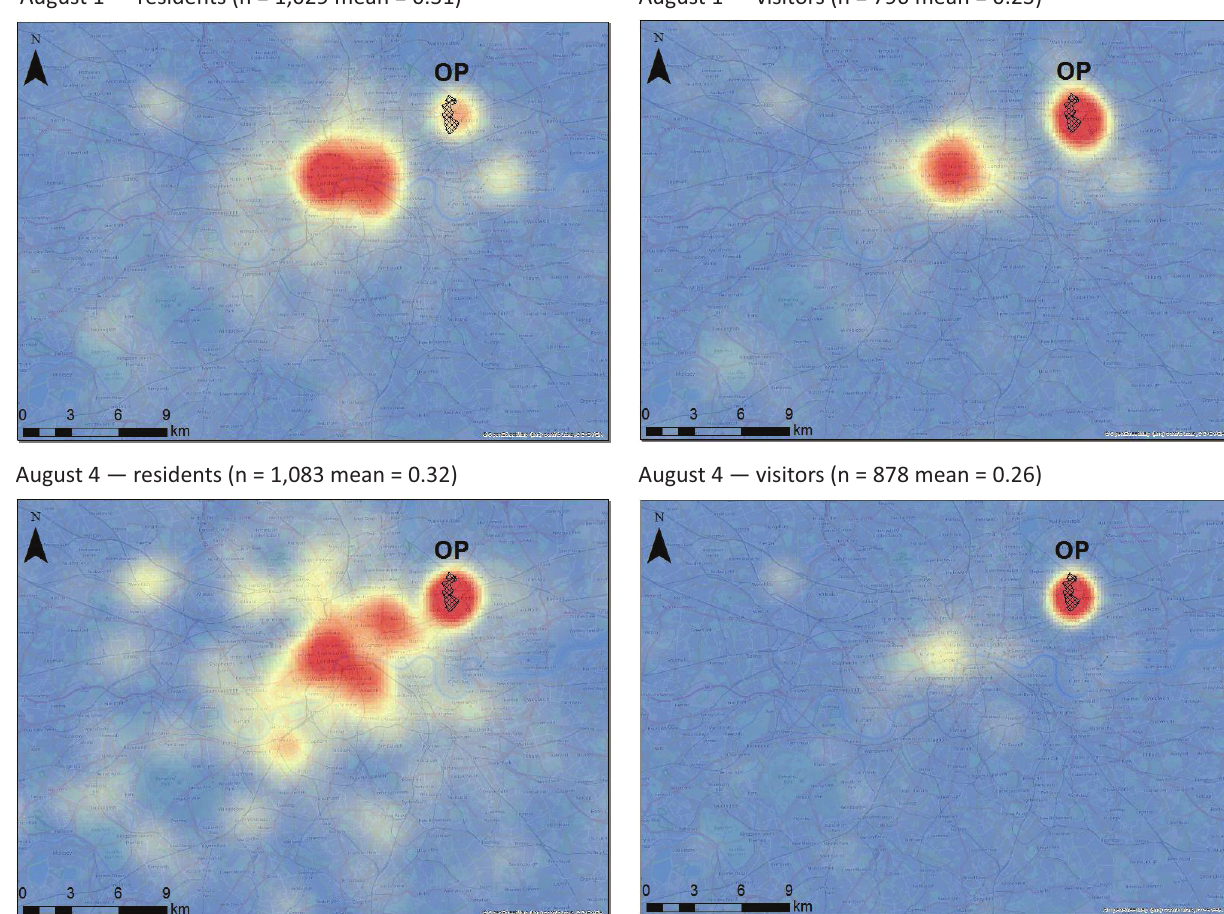
Figure 9. Hot spots of positive tweets (OP = Queen Elizabeth Olympic Park; red = high density, yellow = average density, blue = no